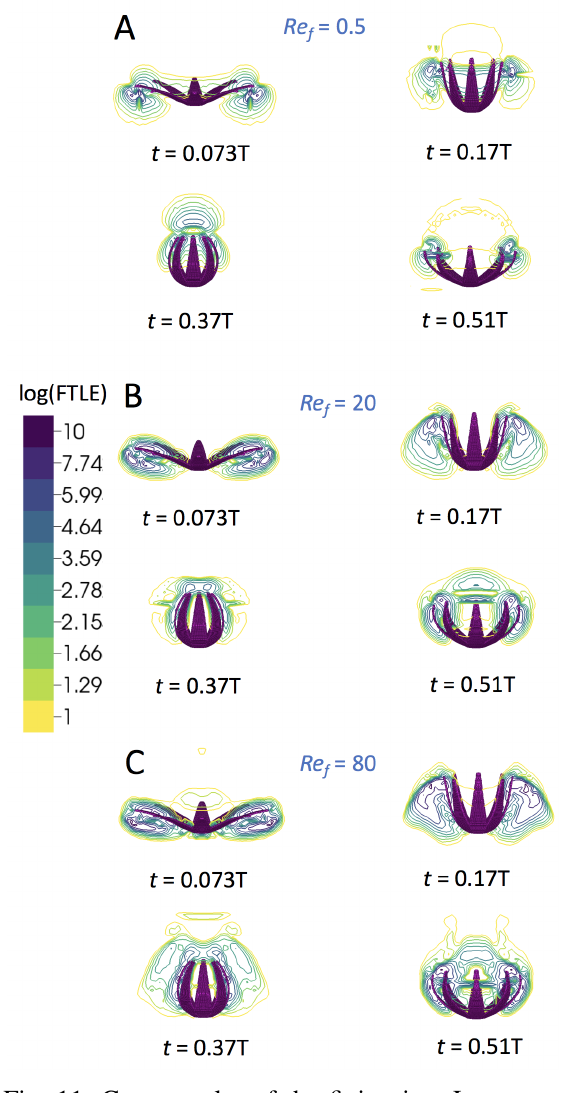
Fig. 11: Contour plot of the finite time Lyapunov exponents (FTLE) illustrating the instantaneous Lagrangian coherent structures during a single polyp’s pulsing cycle for (A) Re f = 0 . 5 , (B) Re = 20 and (C) Re = 80 , using a logarithmic f f